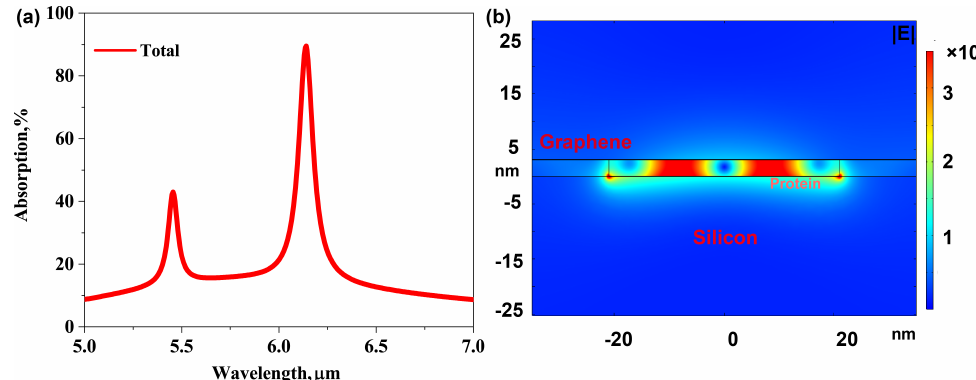
Figure 2. ( a ) The absorption spectrum of bilayer AGPs system for TM waves. ( b ) Electric mode distribution of the bilayer AGP system at wavelength λ 0 = 6.14 µ m. The AGP mode is excited and optical field is confined tightly inside nano-gap of bilayer graphene plasmon cavity.